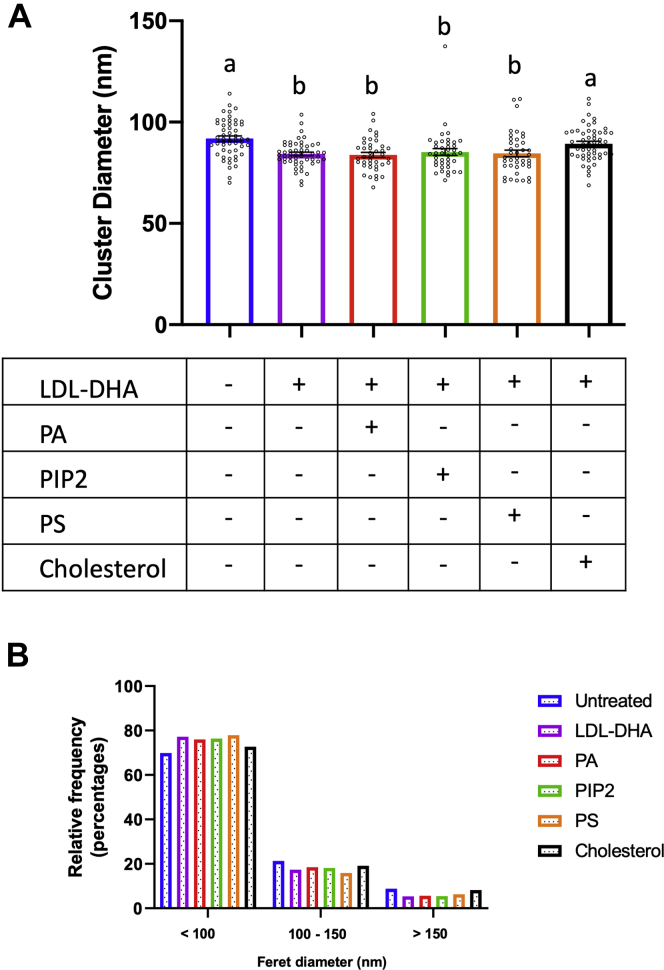
Exogenous cholesterol restores EGFR cluster formation in DHA-treated cells. YAMC cells were untreated or incubated with LDL-DHA (50 μM) for 24 h before the addition of media alone or media supplemented with PA (100 μM), PIP2 (100 μM), PS (100 μM), or cholesterol (1 mM) for 30 min at 33°C, before fixation and labeling with EGF-Alexa647 for STORM imaging. A: Quantitative analysis of EGFR cluster diameter and (B) relative frequency in YAMC cells. Data are presented as (A) mean ± SE of average EGFR cluster diameter per FOV and (B) individual cluster size distribution. Number of FOVs examined per treatment, untreated = 52, LDL-DHA = 52, LDL-DHA + PA = 40, LDL-DHA + PIP2 = 40, LDL-DHA + PS = 40, LDL-DHA + cholesterol = 52, and individual clusters, untreated = 6,196, LDL-DHA = 5,435, LDL-DHA + PA = 3,451, LDL-DHA + PIP2 = 2,319, LDL-DHA + PS = 2,870, LDL-DHA + cholesterol = 5,790, from five wells per group from three independent experiments. Statistical significance between treatments as indicated by uncommon letters (P < 0.005) was analyzed using one-way ANOVA and uncorrected Fisher's LSD tests.